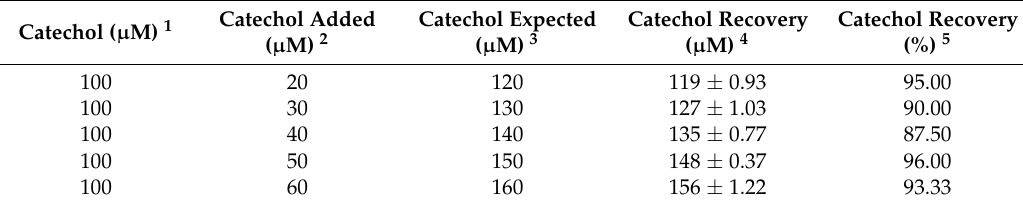
Table 2. Recovery assay results for catechol standard using the jenipapo PPO biosensor. Catechol ( µ M) 1